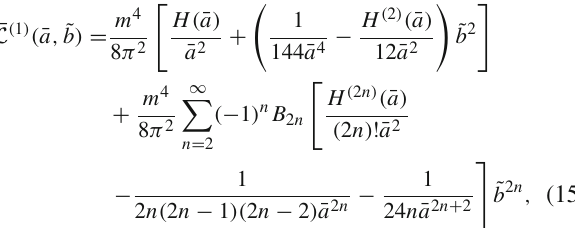
Fig. 3 The influence of the imaginary part of part of ¯ L ( 1 ) ( ¯ a , ˜ b ) : (a) P Im / P Re and (b) M Im / M Re . The parallel field configuration in Table 1 was assumed, and ¯ L ( 1 ) ( ¯ a , ˜ b ) was calculated numerically with the first 10 poles, as described in Appendix A. The filled squares mark the